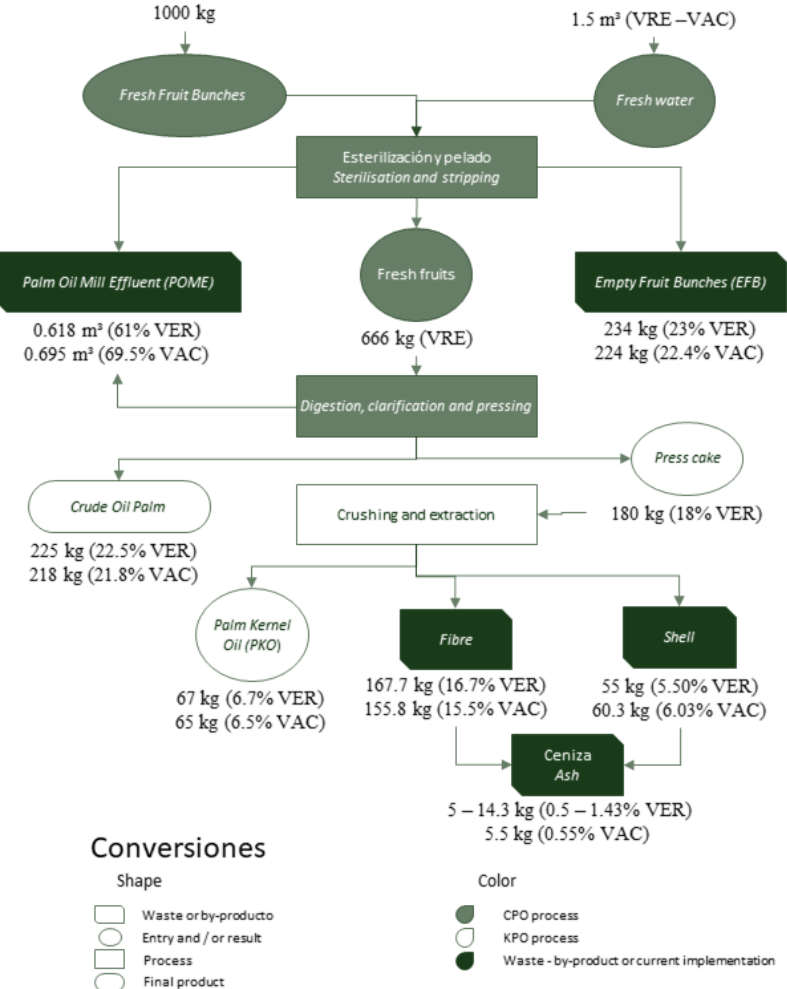
Figure 1. Diagram of the inputs and outputs of matter in the transformation process of 1 ton of RFF. Source: Adapted from Loh [39] and Abdulalla [34].